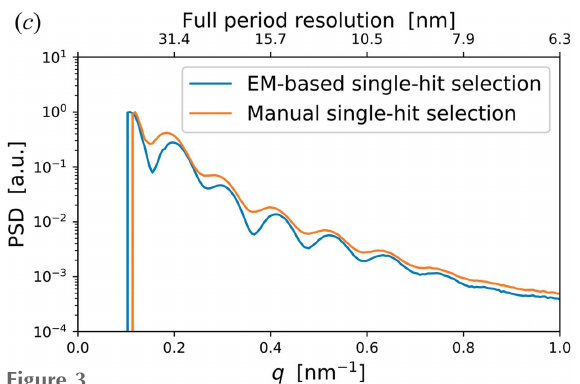
Figure 3 Classification of diffraction patterns by EM clustering. ( c ) Averaged PSD functions for EM-based single-hit selection containing 1085 patterns (blue line) and for manual selection containing 1393 patterns (orange